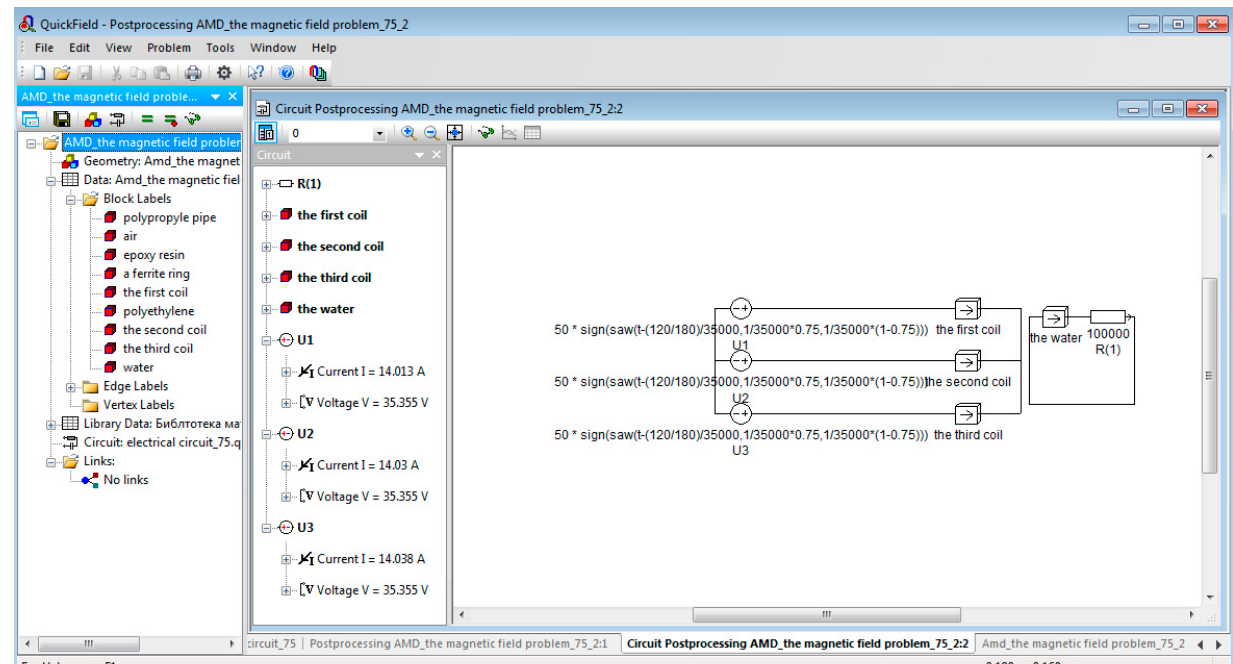
Figure 9. Circuit postprocessing.